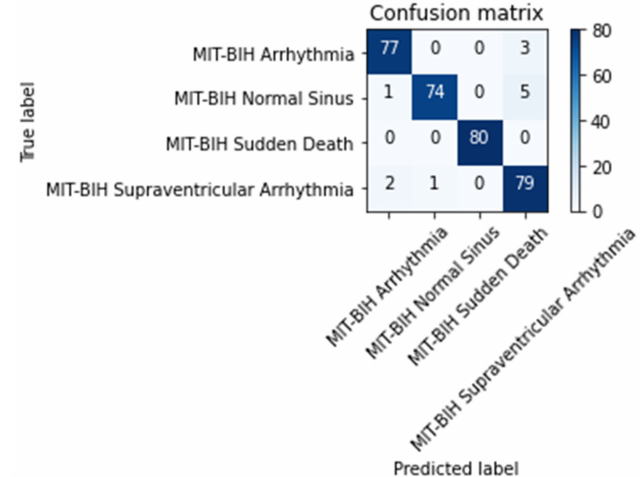
Figure 10. Confusion matrix of CNN prediction of testing data (80 ECG images for each